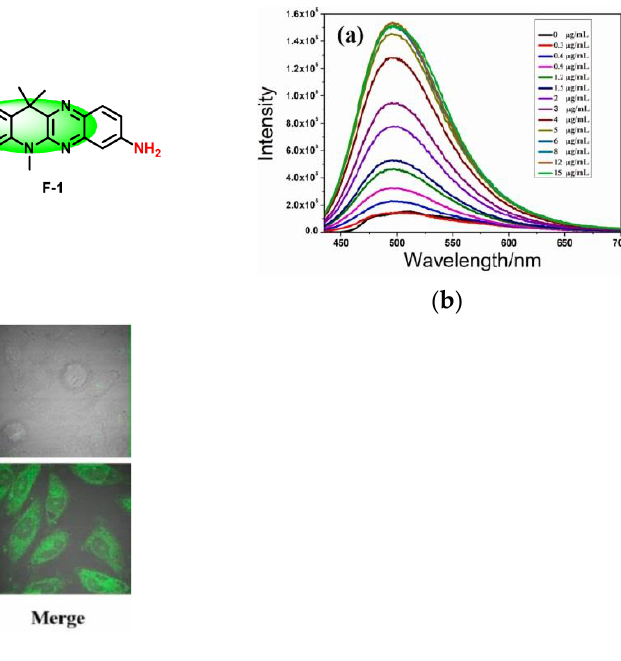
probe T-1 upon addition of different concentrations of NTR; ( c ) Confocal images of HeLa cells under different O 2 conditions incubated with probe T-1. Reproduced with permission from [62].